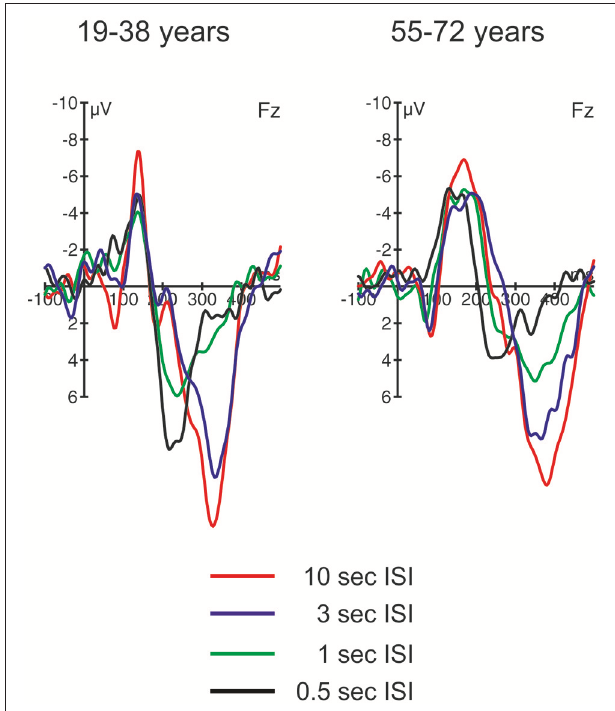
FIGURE 4 | ERP difference waves (i.e., ERPs elicited by novel stimuli minus ERPs elicited by standard stimuli) at Fz in the four different ISI conditions, separated for the two groups of